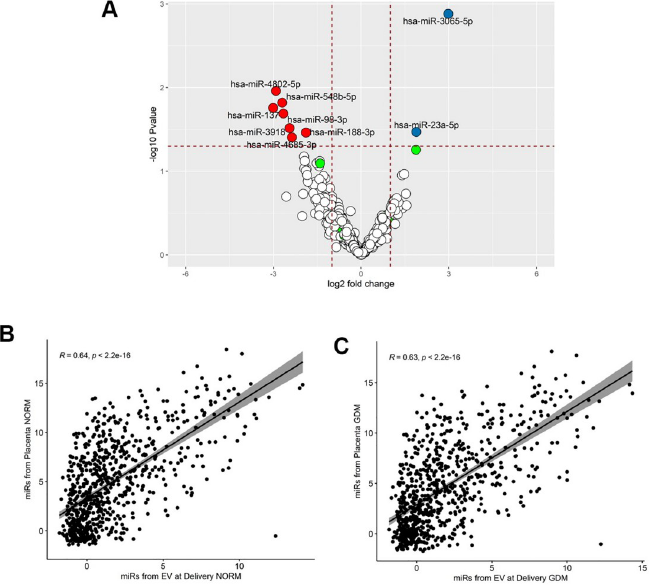
Fig 6. Differential abundance of miRNAs in placental tissue. Volcano plots show expression of miRNAs in term placental tissue from pregnancies complicated by (A) GDM compared to normal pregnancies. Correlation between miRNAs from the term placenta and EV-derived miRNAs isolated from maternal plasma at delivery was performed in (B) normal pregnancy and (C) GDM.